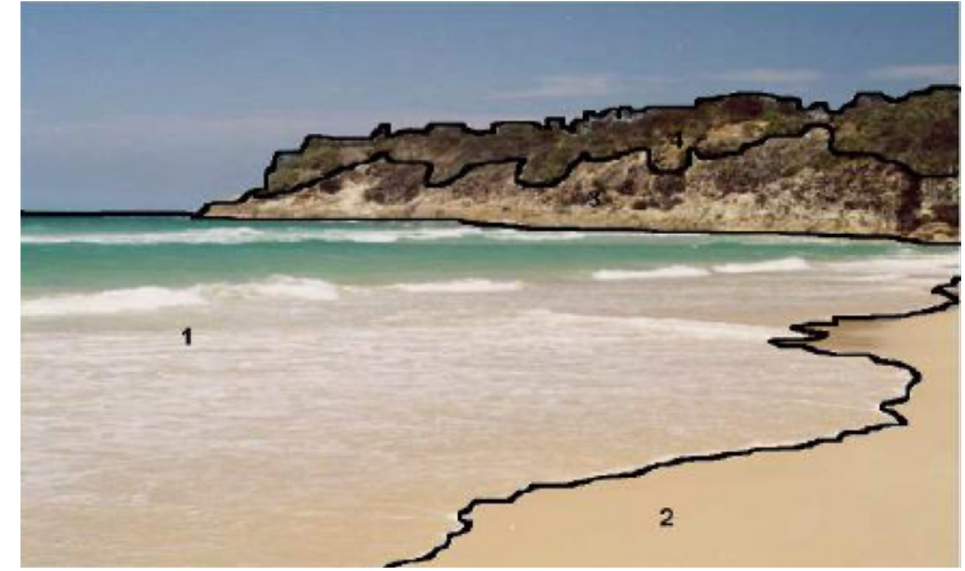
Figure 4. An example of a sketch delineating visual elements on a photograph. The area of each polygon is measured, and its proportion of the total non-sky area entered into SEQ SPRAT to estimate the view’s scenic preference rating. In this image, 1 indicates bay and 2 sand beach. Source: [26] (p. 9). Two methods are available to determine the scenic preference of new locations using a minimum of three photographs taken to represent views from the development site